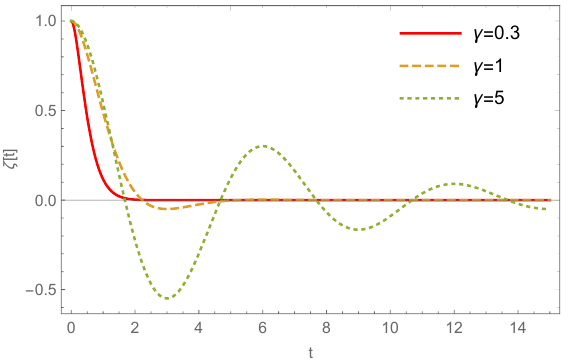
Figure 7 . The friction kernel of the oscillating friction for different decay coefficient γ . In the plots, ζ = 1 , and ˜ ω = π 3